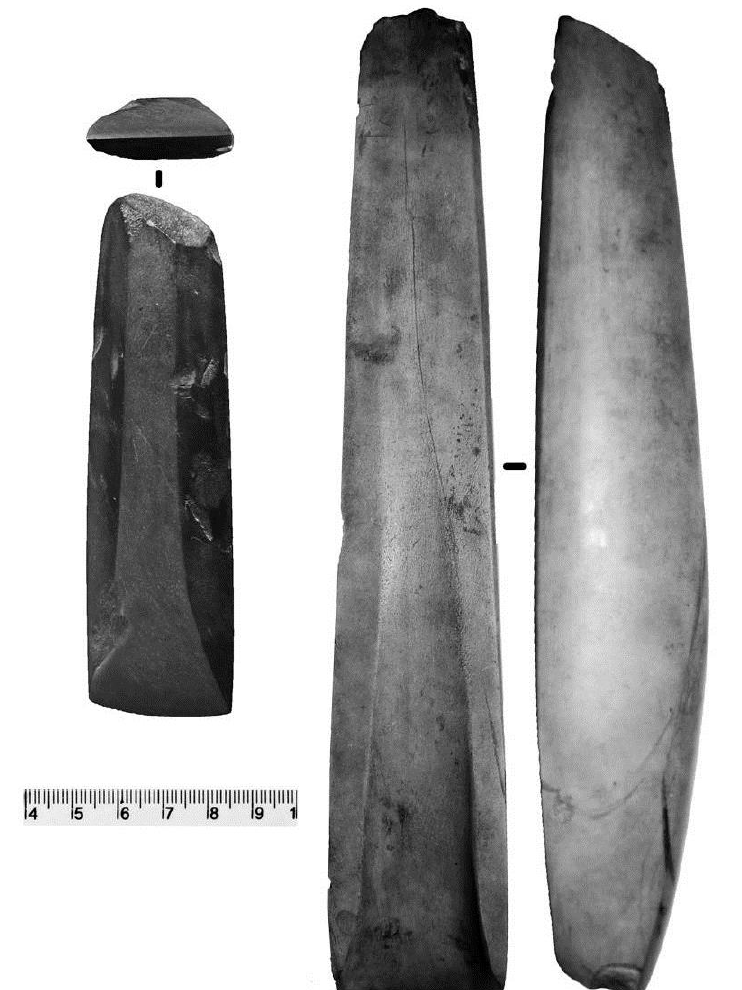
Figure 2. Typical tools of the Russian Karelian type (metatuff). 1 – adze (Karelia, Fofanovo XIII workshop site, preserved in ILLH KRC of RAS, Petrozavodsk), 2 – gouge (Estonia, Aesoo, stray find, preserved in Institute of History in Tallinn). Photo by A. Tarasov, A. Kriiska